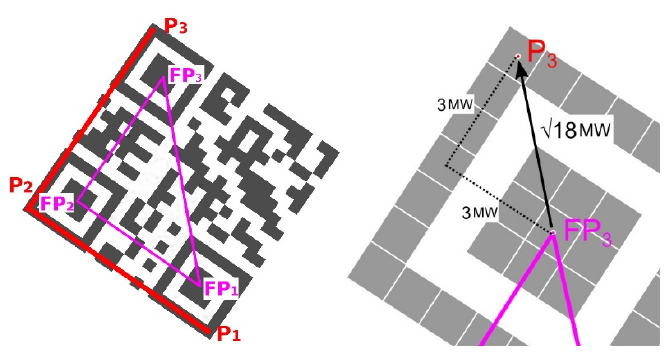
Figure 10. Bounding box. Figure 10. Bounding